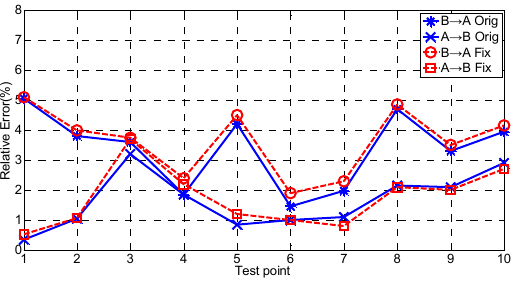
Figure 14. Distribution of relative error.